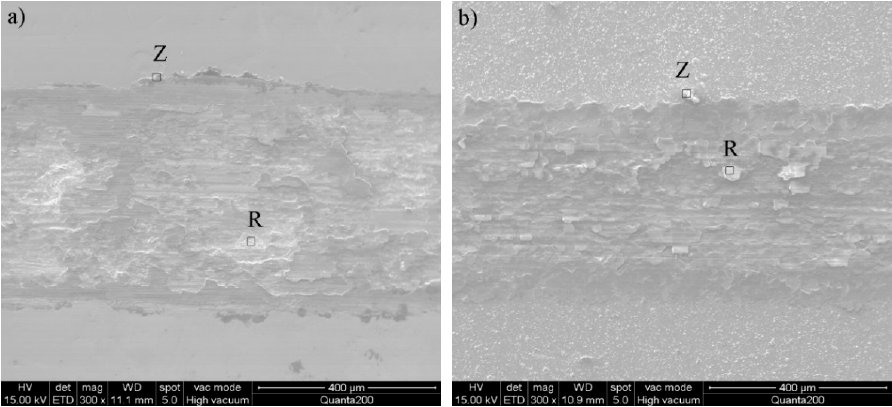
Figure 5. SEM morphologies of the worn surfaces of No. 1 specimens: ( a ) uncoated, ( b ) coating. Table 8. Compositions of typical regions of the worn surfaces of No. 1 coating and uncoated specimens on EDS.